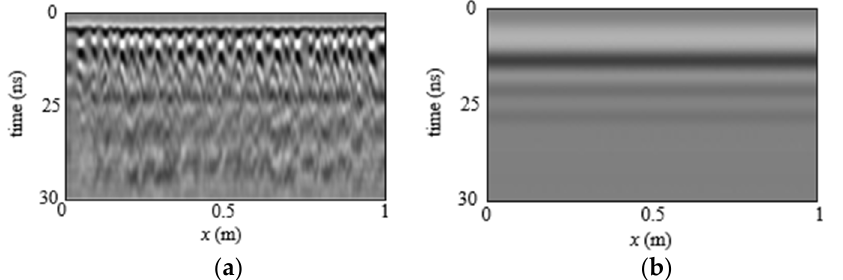
Figure 5. When only the 400 MHz antenna is moved, only changes occur in the ( a ) 400 MHz radar signal, and the ( b ) 900 MHz radar signal remains stable.